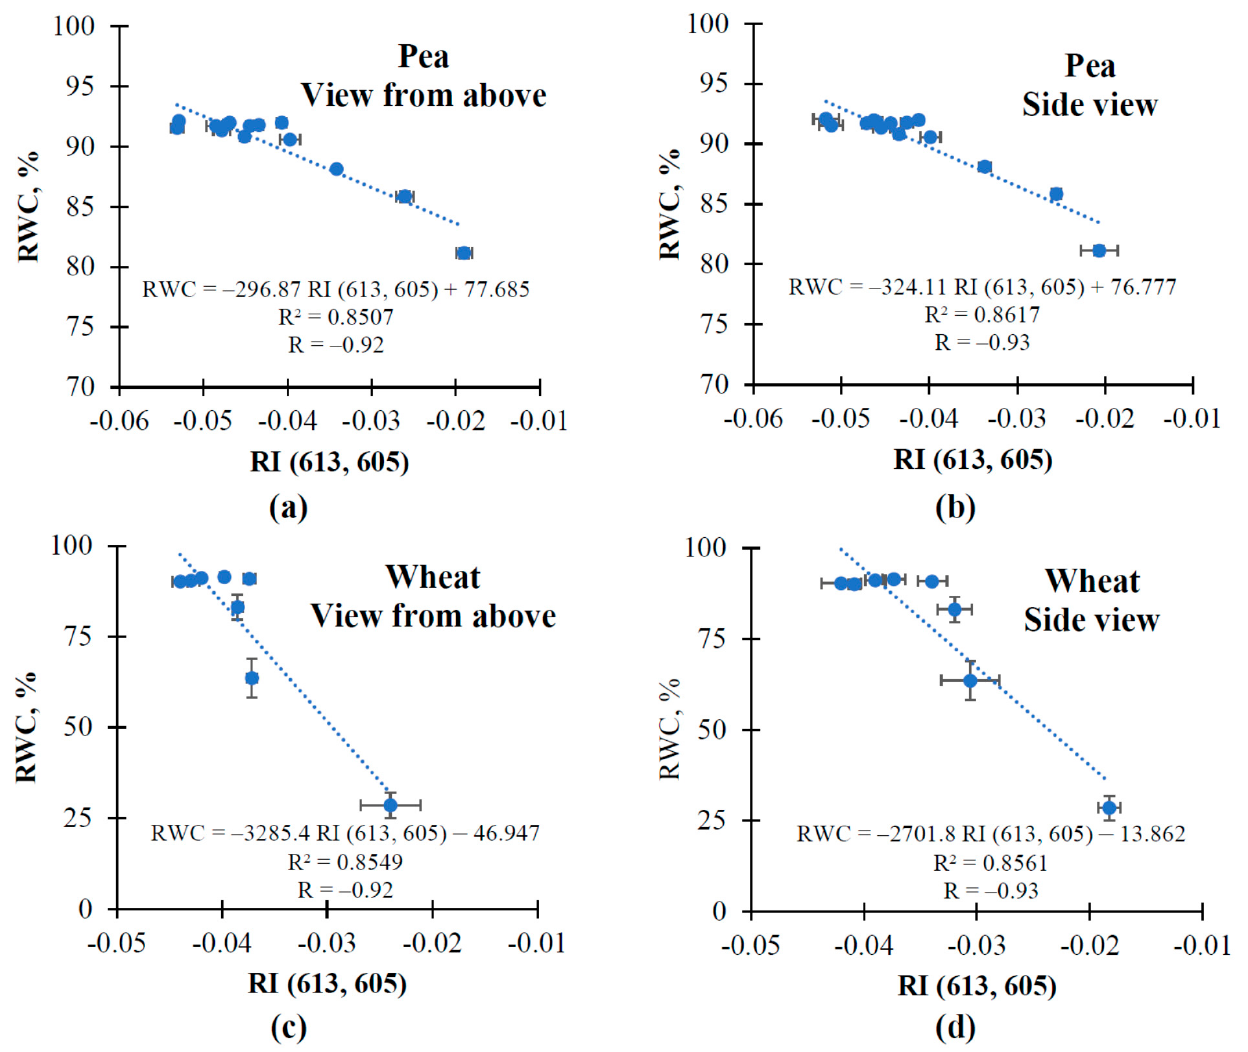
Figure 4. Scatter plots between RWC and RI (613, 605) which were measured in pea plants from the view from above ( n = 14) ( a ), in pea plants from the side view ( n = 14) ( b ), in wheat from the view from above ( n = 8) ( c ), and in wheat from the side view ( n = 8) ( d ). Corresponding averaged values from Figures 2 and 3 were used for the scatter plots. R and R 2 are correlation and determination coefficients. Correlation coefficients were significant for all considered causes.